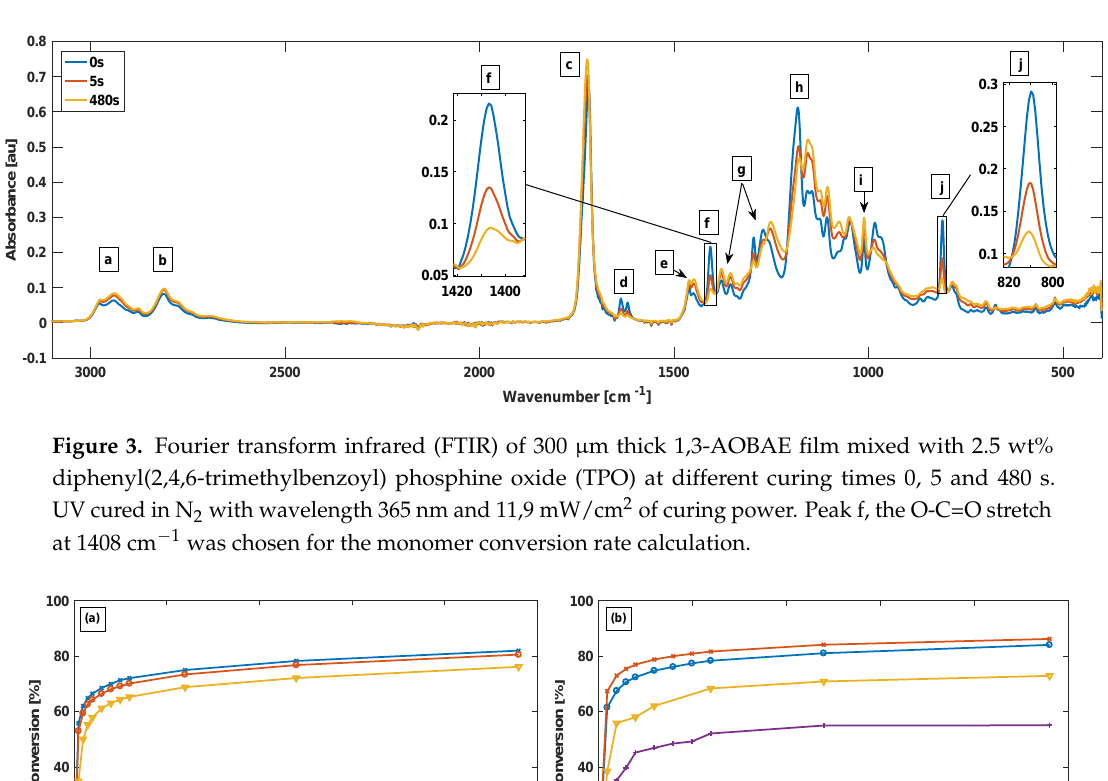
typical C-N bands from PIP [21]; (h) 1181 cm − 1 and 1158 cm − 1 C=O stretch, shift is due to solidification;